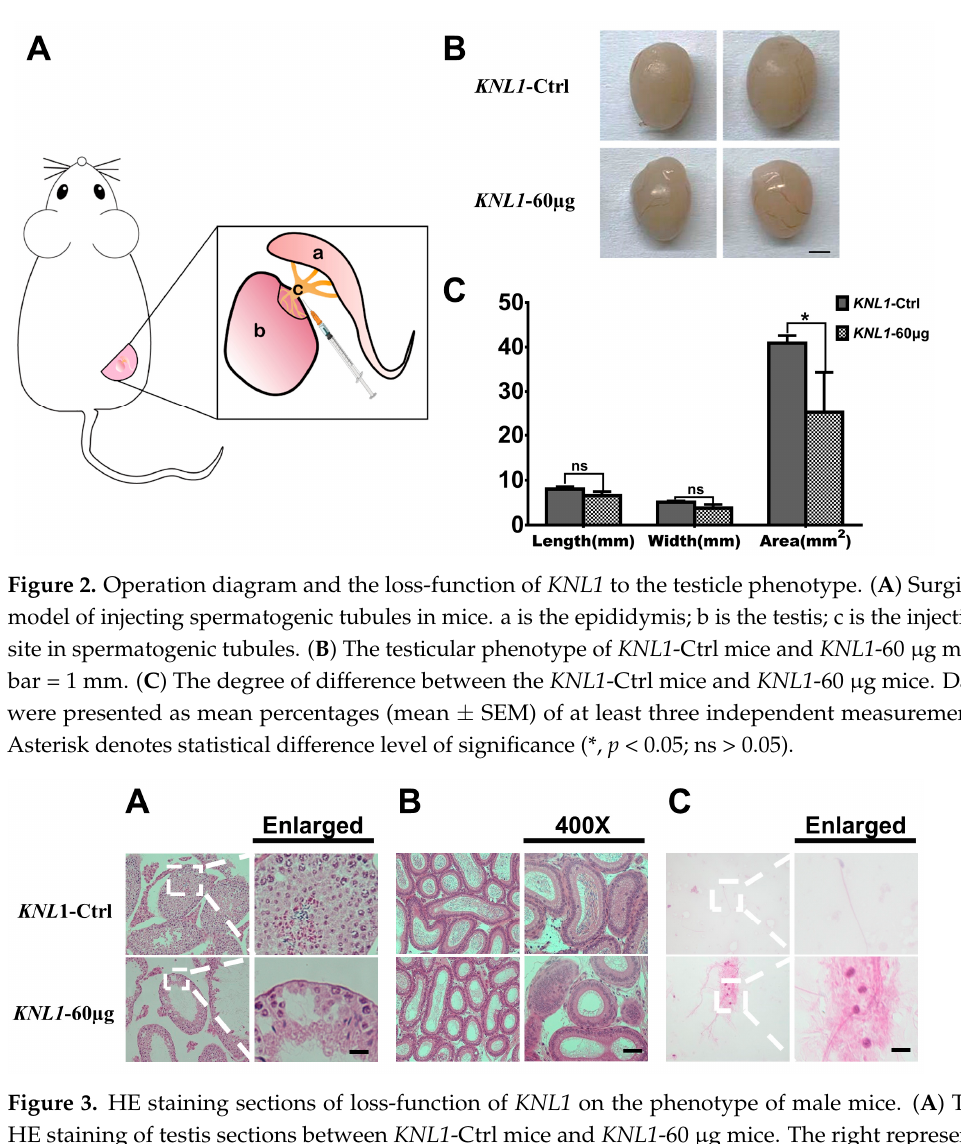
Figure 3. HE staining sections of loss-function of KNL1 on the phenotype of male mice. ( A ) The HE staining of testis sections between KNL1 -Ctrl mice and KNL1 -60 µ g mice. The right represents the magnified portion of the white dashed box in the left line. Bar = 20 µ m ( B ) The HE staining of epididymis sections between KNL1 -Ctrl mice and KNL1 -60 µ g mice. The left is a 200 × magnification